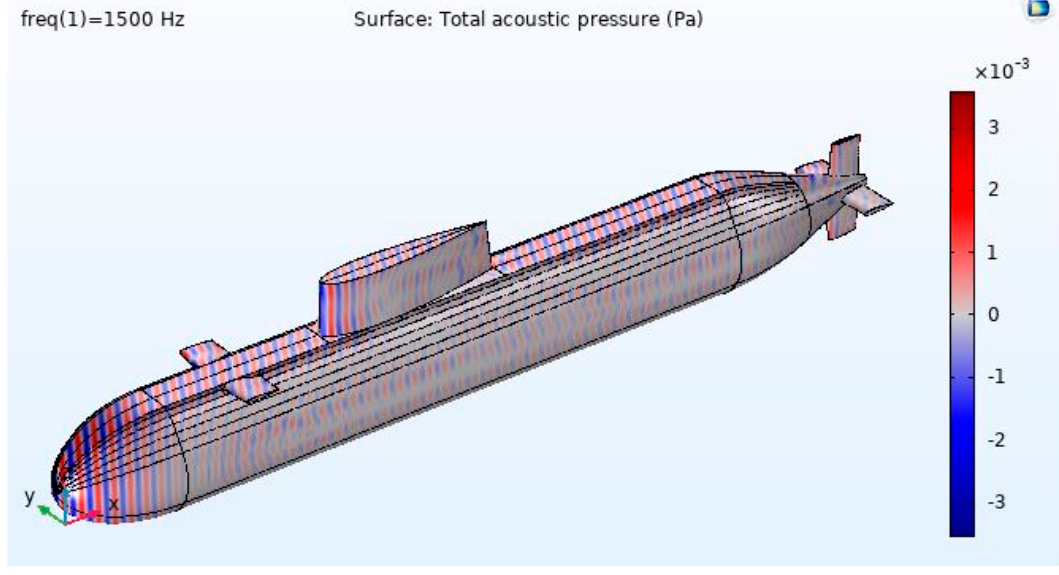
Figure 4. The total acoustic pressure that was measured at the submarine. Figure 5 illustrates the radiation pattern that would be observed at a distance of one hundred meters from the submarine. To illustrate this, an arrow has been drawn in the general direction that the sound will move. It is important to note that the scattered signal at this frequency has intricate lobes and is extremely